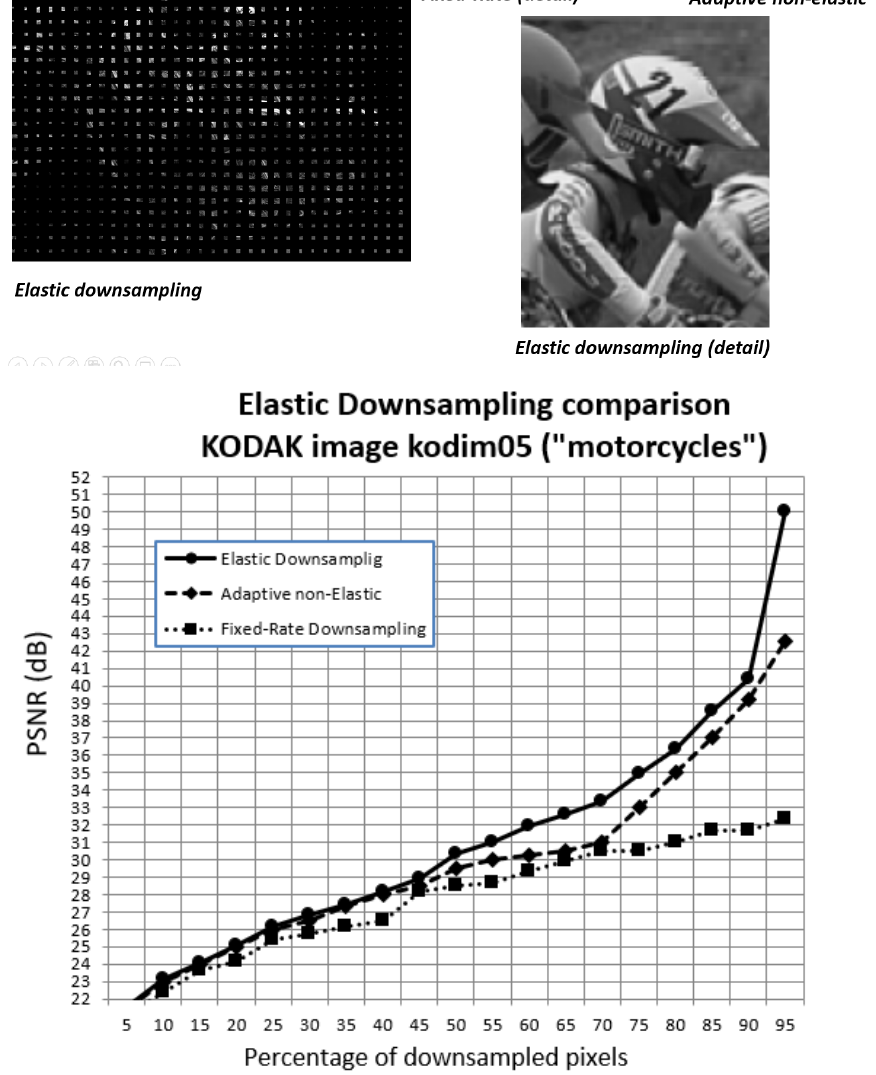
Figure 14. Elastic downsampling results for the “motorcycles”